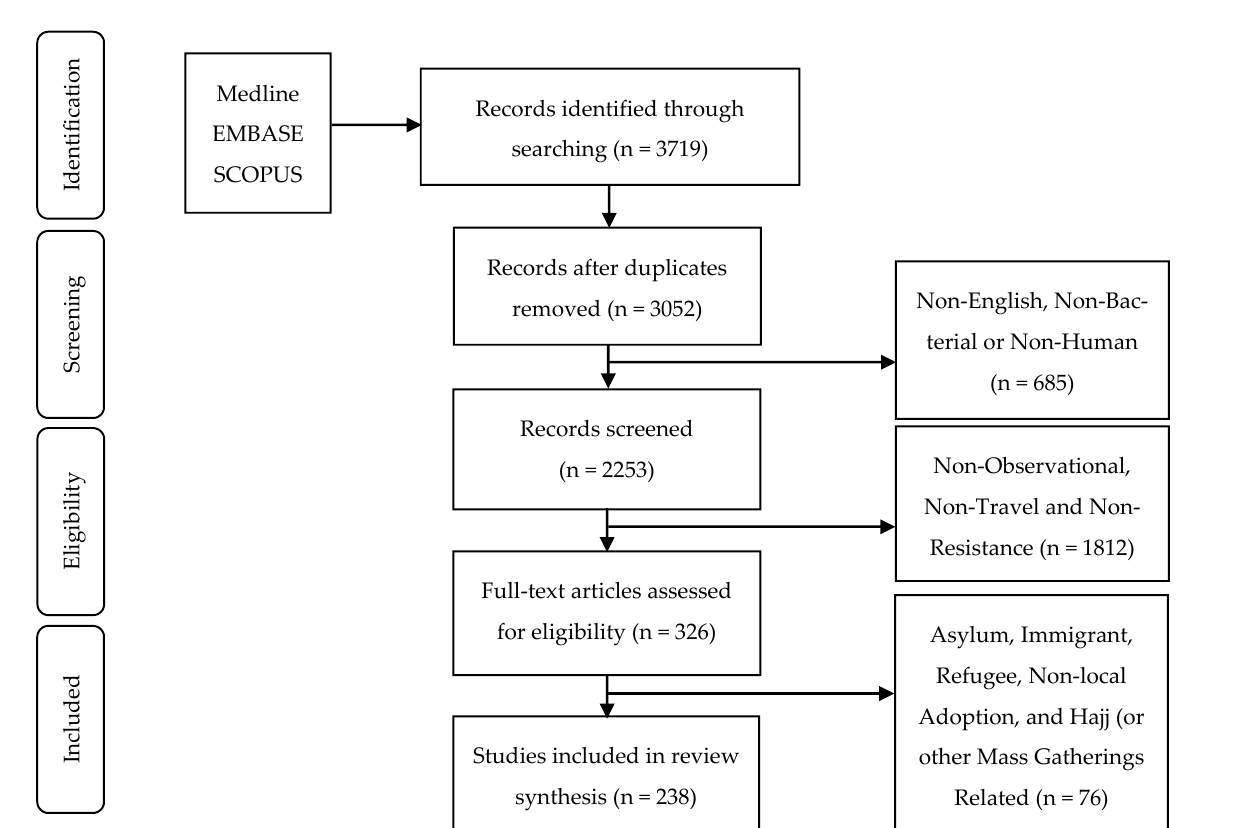
Figure 1. Preferred reporting items for systematic reviews and meta-analyses (PRISMA) flow diagram for the current systematic review: the methods used for search, identification, screening and the selection process for our review.